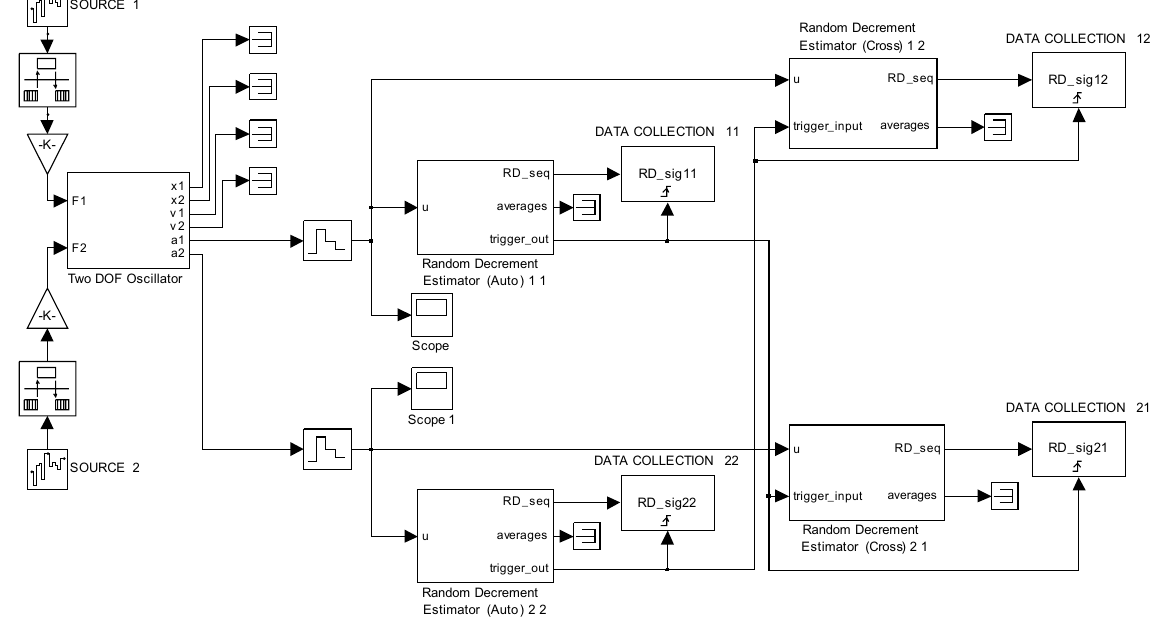
Fig. 5. Time domain system simulation of a mechanical system and the RD